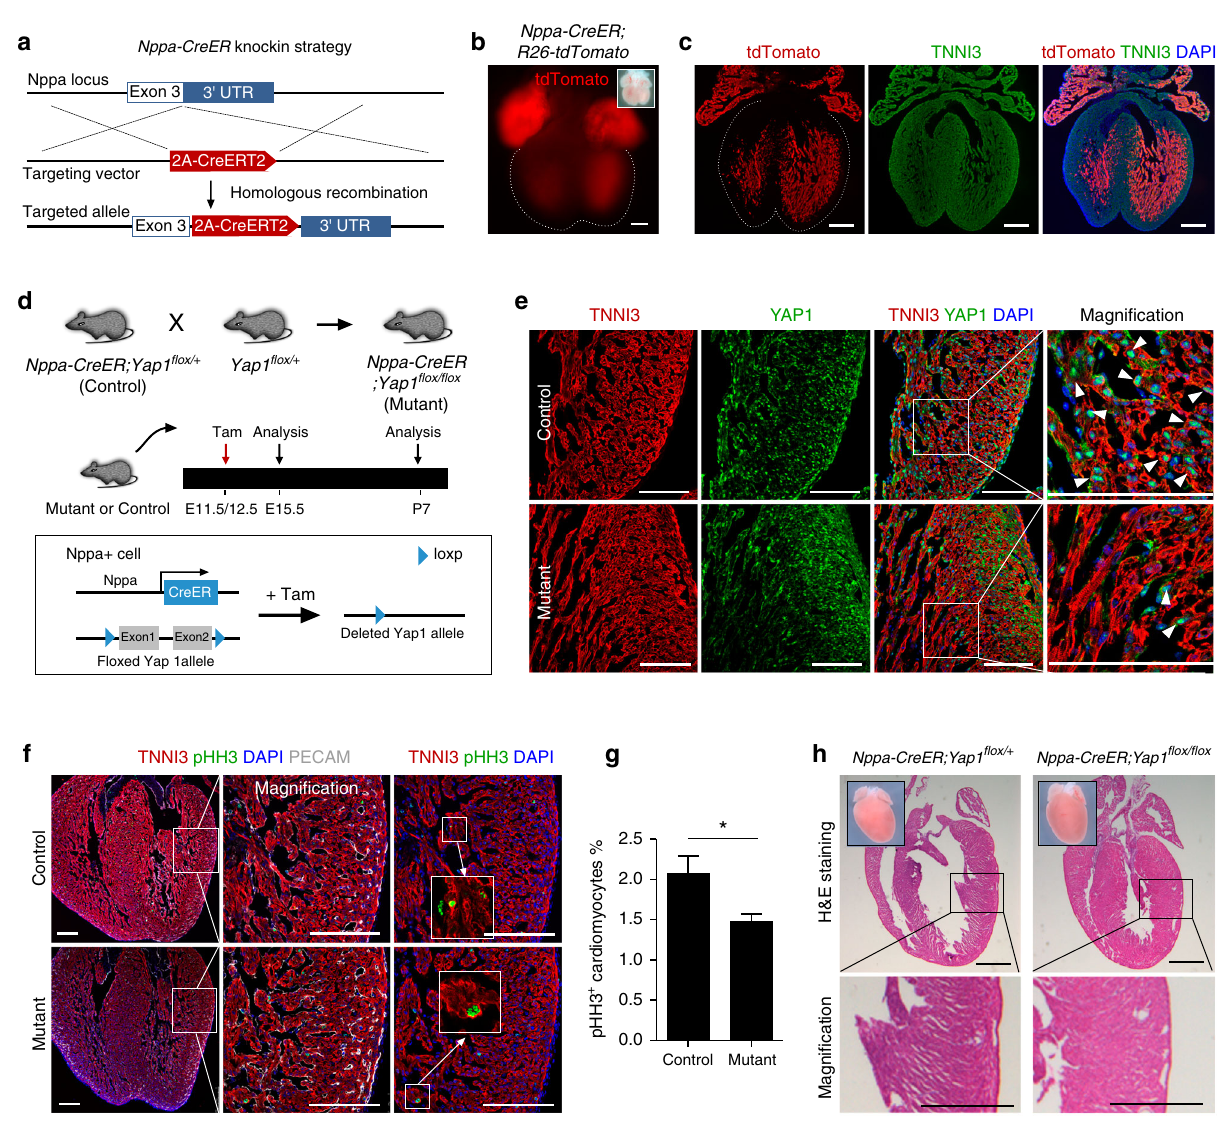
Fig. 10 Deletion of Yap1 in fetal trabecular myocardium does not result in thin compact myocardium. a Schematic fi gure showing generation of Nppa-CreER knock-in allele. b Whole-mount fl uorescence view of E15.5 Nppa-CreER;R26-tdTomato heart. Tamoxifen was injected at E12.5. c Immunostaining for tdTomato and TNNI3 on heart section showed Nppa-CreER mainly targets trabecular myocardium. d Schematic fi gure showing strategy for Yap1 knockout and experimental design. e Immunostaining for YAP1 and TNNI3 on control or mutant heart sections shows a signi fi cant reduction of YAP1 + cardiomyocytes ( arrowheads ) in the mutant compared with the control. f Immunostaining for pHH3, TNNI3 and PECAM on the E15.5 mutant or control heart sections. g Quanti fi cation of the percentage of pHH3 + cardiomyocytes in trabecular myocardium of the control and mutant heart samples. * P < 0.05; n = 4. h Hematoxylin and eosin (H&E) staining of heart sections from P7 control and mutant hearts. Inserts indicate whole-mount images of hearts. Scale bars, 1 mm in h ; 200 µ m in b ; 100 µ m in c , e ,